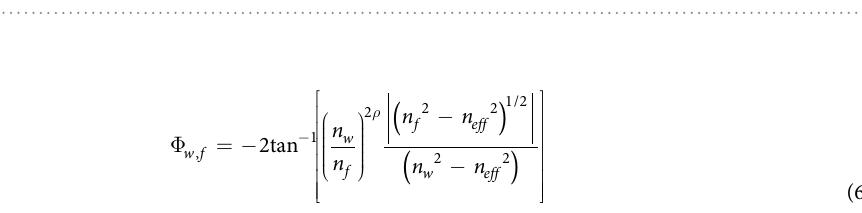
Figure 2. Phase curve of the GMR signal. Phase curve of the reflection spectrum of the GMR sample showing a rapid change in the phase value corresponding to the experimentally obtained resonance peak wavelength of 632.8 nm. Both amplitude reflectance and phase curves are shown. The curve has been produced using FDTD simulation